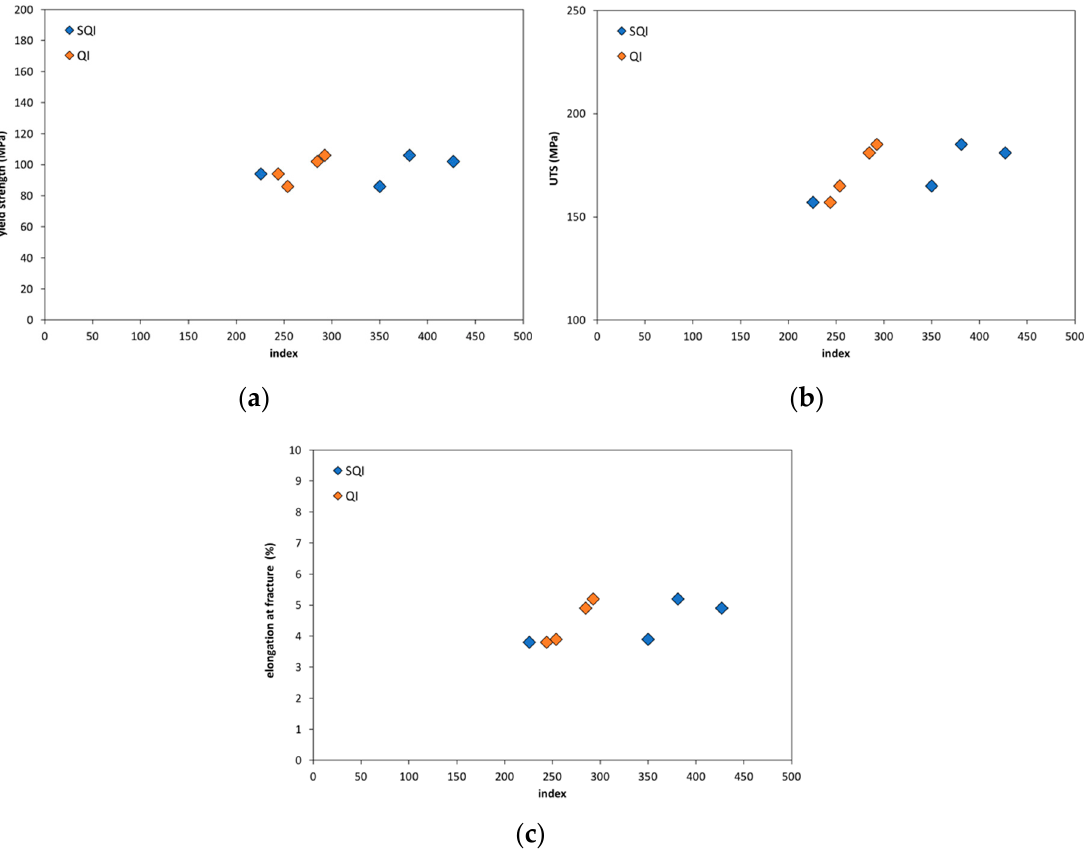
Figure 12. Comparison of quality indices with mechanical properties ( a ) Yield strength, ( b ) Ultimate tensile strength, ( c ) elongation at fracture.